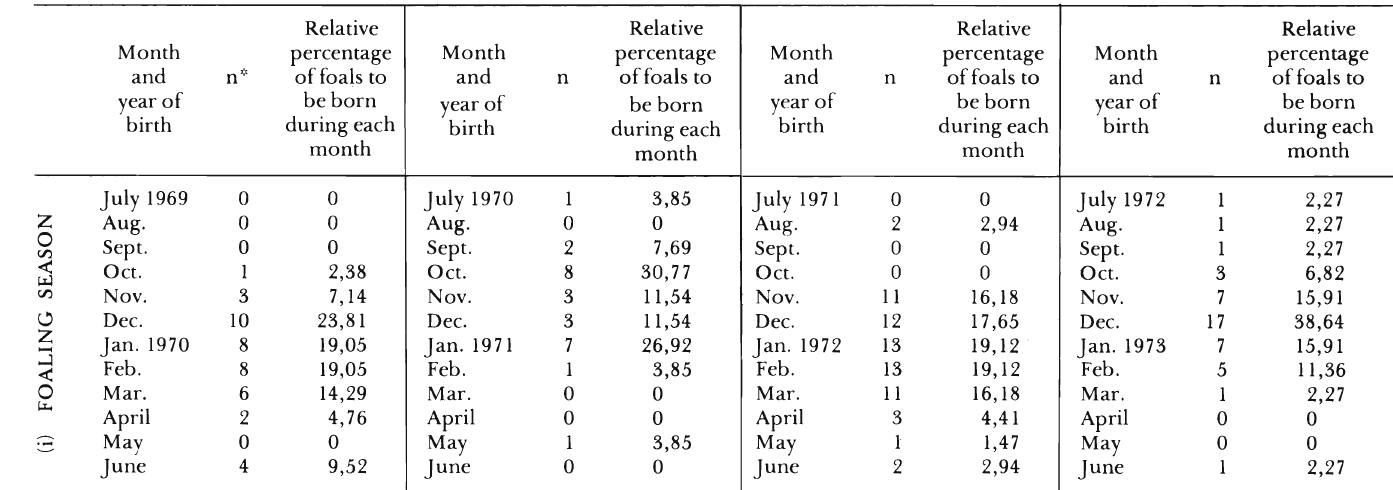
Sea.lOnal distribution of births (i) and conceptions (ii) for Burchell's z.ebra collected in the Central Di.ltrict of the Kruger National Park between May 1969 and November 1972. (n = 180